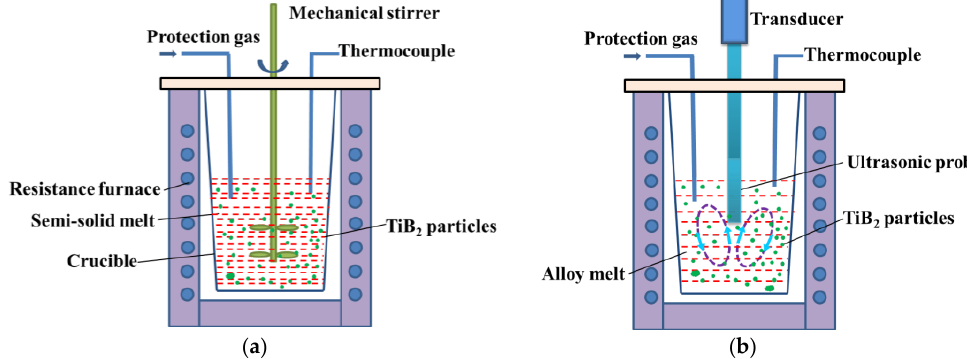
Figure 2. Schematic of the fabrication process of TiB 2 / Mg-4Al-1.5Si alloy composites, ( a ) mechanical stirring in semi-solid state, ( b ) ultrasonic treatment in the liquid state.